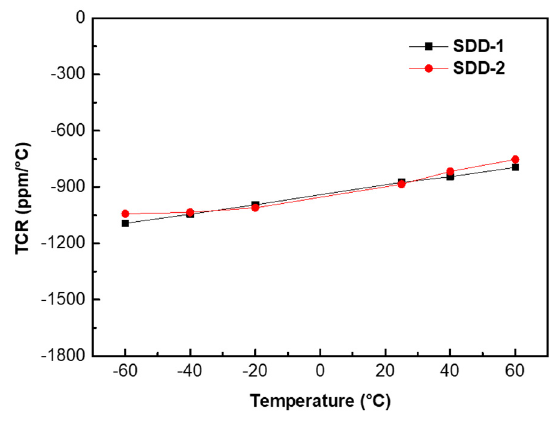
Figure 9. TCR values are calculated as a function of the test temperature for the voltage dividers of SDD-1, SDD-2 at the temperature range from − 60 °C to 60 °C, respectively. SDD-1, SDD-2 at the temperature range from − 60 ◦ C to 60 ◦ C, respectively.